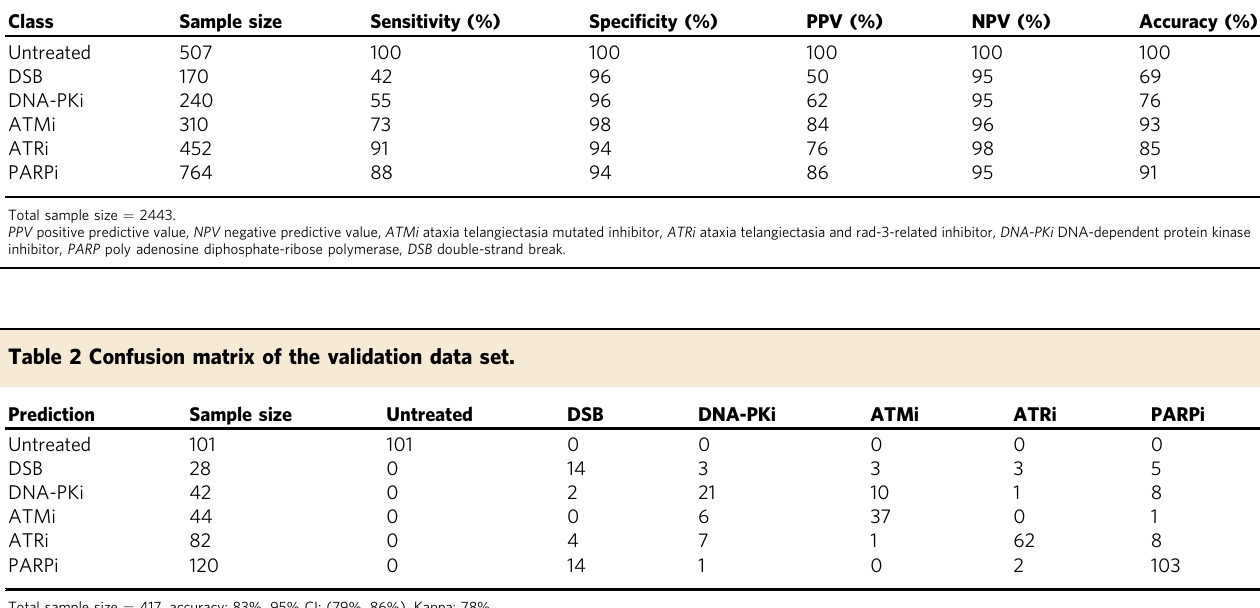
Table 1 Machine learning model analysis with Random Forest (model